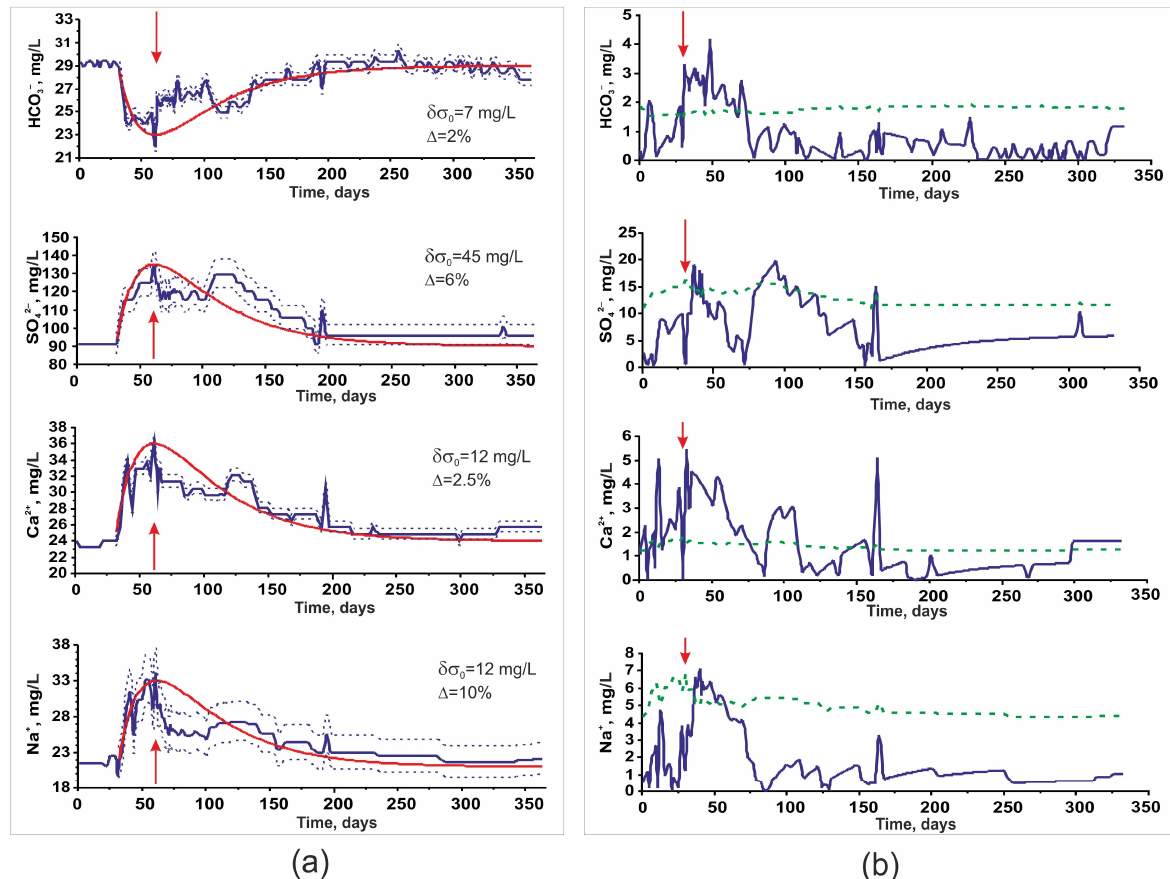
Figure 6. ( a ) Changes in HCO 3 − , SO 42 − , Ca 2+ , Na + concentrations in water from well M-1 due to earthquake on 2 March 1992 (earthquake moment—red arrow) and results of calculations according to (3) at t 0 = 20 days and τ 0 = 50 days. Blue lines—observational data; blue dotted lines—interval of concentration taking into account the error of determination ∆ i according to (1); red lines—calculated concentrations; δσ 0 —amplitude of precursor anomaly. ( b ) Changes in the absolute values of residuals between the measured concentrations and calculated values (blue lines) in comparison with the double error ∆ i in determining each concentration value (green dashed